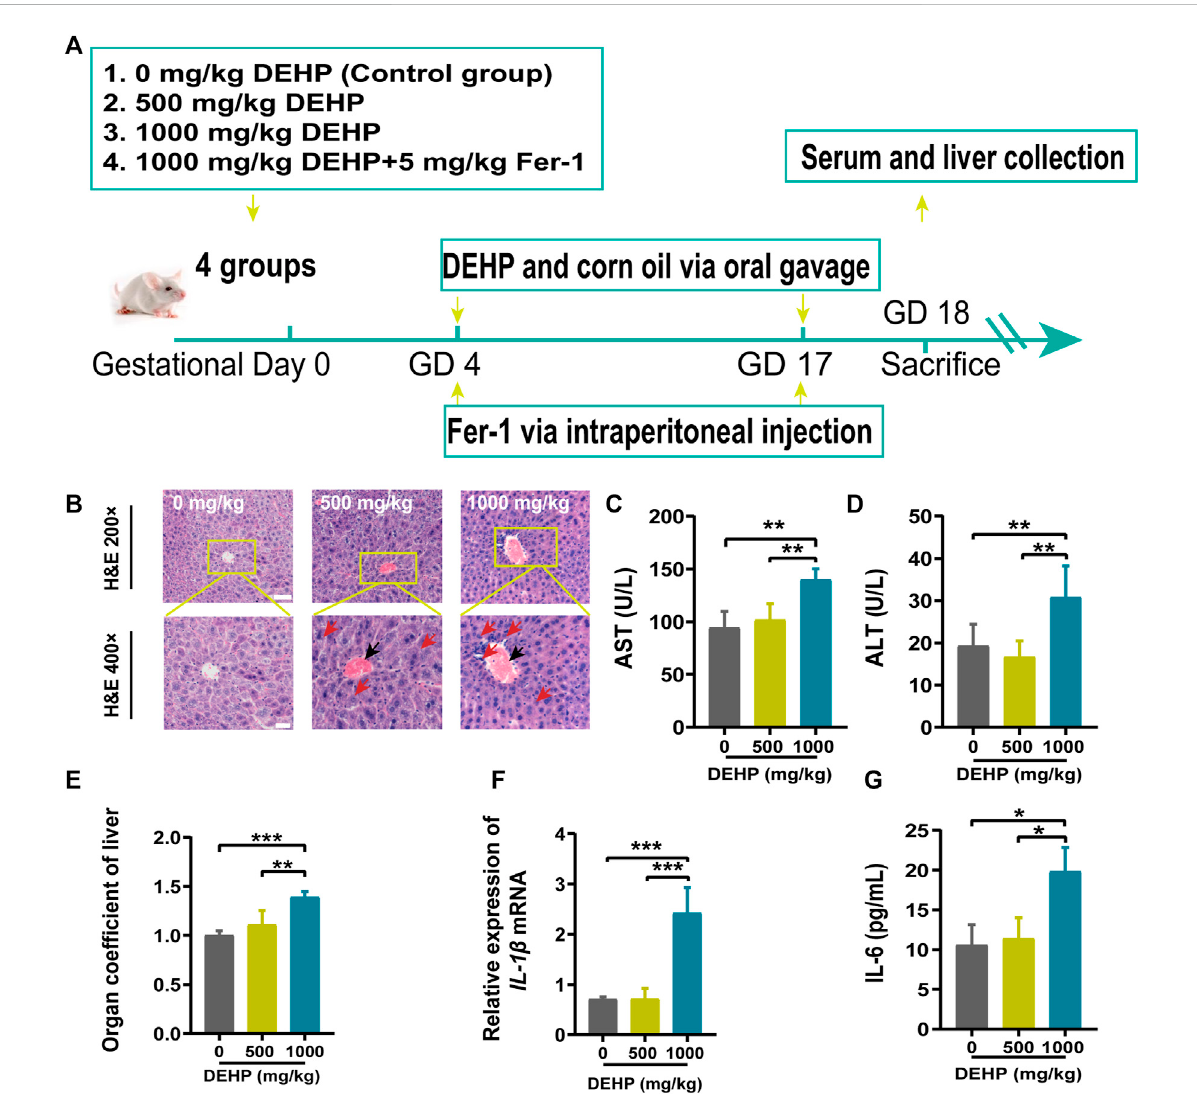
FIGURE 1 DEHPexposureresultedinliverinjuryinpregnantmice. (A) Thetreatmentscheduleperformedinmice. (B) LiversectionswerestainedwithH&E. H&E magni fi cation, fi rst row, 200× (scale bar = 100 μ m); second row, 400× (scale bar = 50 μ m). The red arrow indicates hepatocyte swelling, necrosis, and in fl ammatory cell in fi ltration, and the black arrow indicates hyperemia in the central vein in the DEHP-treated groups. (C,D) Serum levelsofASTandALT. (E) Theratiooftheliverweighttothebodyweight. (F,G) RT-qPCRofthein fl ammatoryfactor IL-1 β andtheserumlevelsof IL-6. All serum indexes were tested by kits. Data are presented as the mean ± SD. AST, aspartate aminotransferase; ALT, alanine